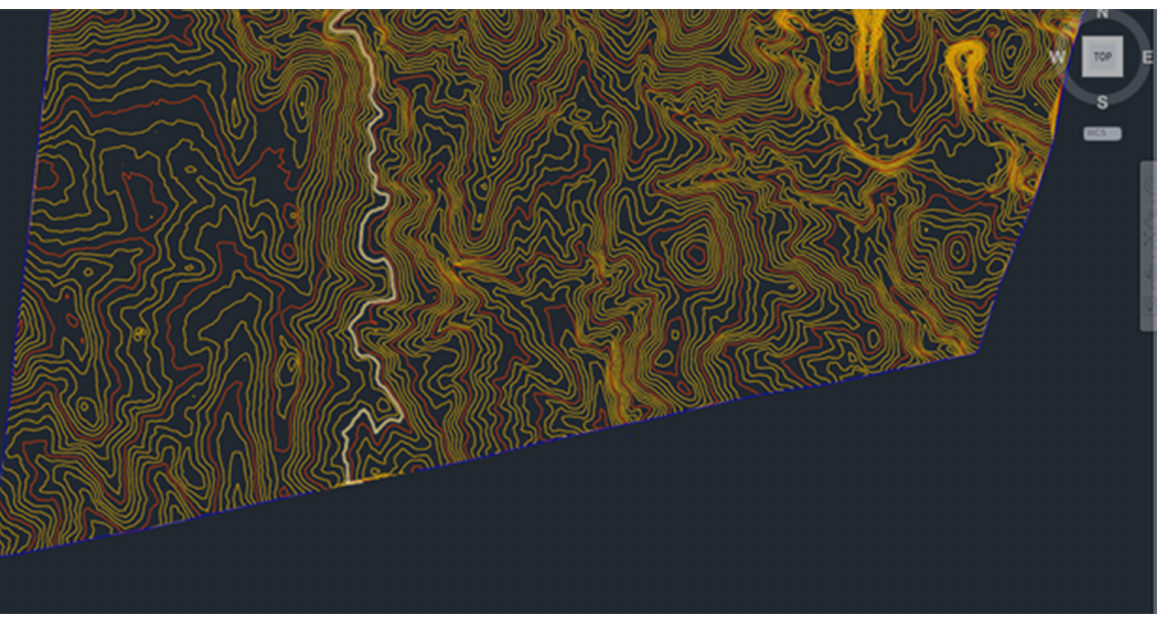
Fig. 5. From point cloud data to minor and major contours using AutoCAD